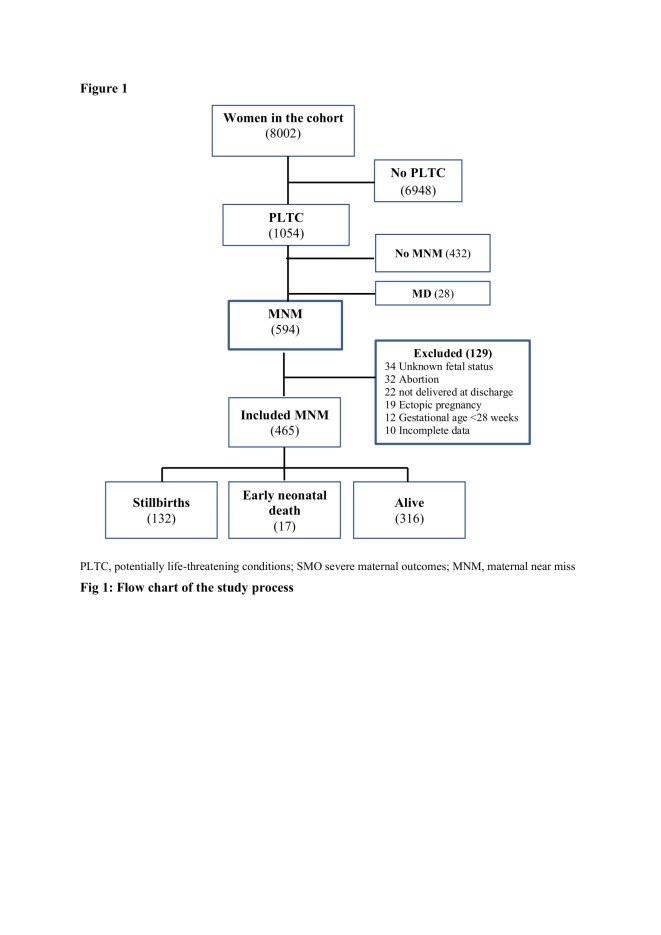
Flowchart describing the inclusion process in the study. PLTC – potentially life-threatening conditions, SMO – severe maternal outcomes, MNM – maternal near miss.